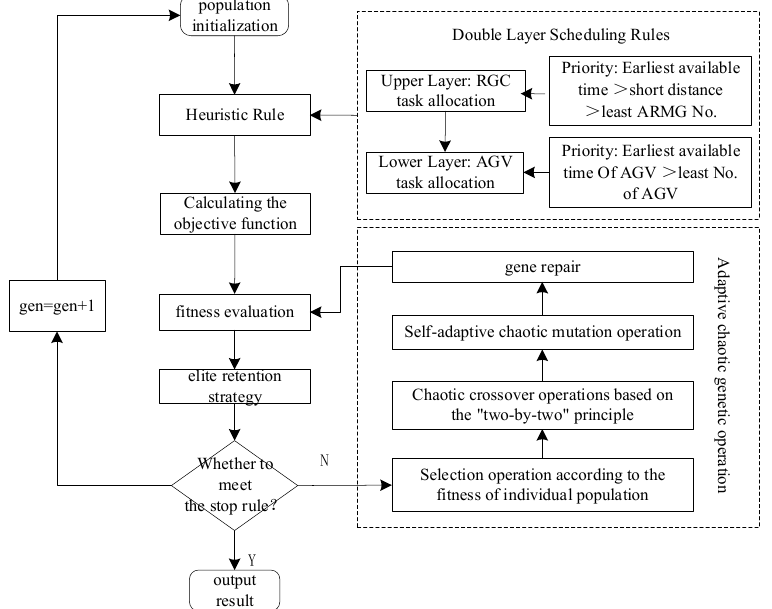
Figure 5. Flowchart of the self-adaptive chaotic genetic algorithm.